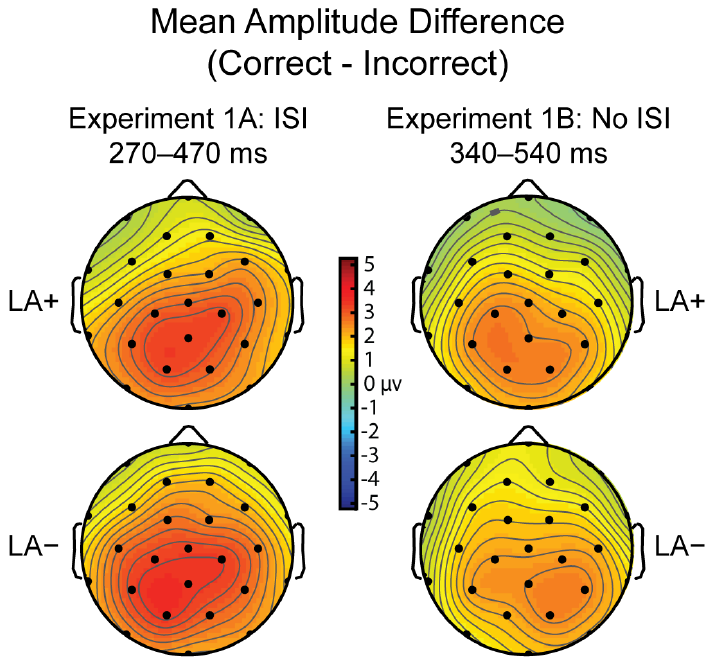
Figure 6. Topographic (isovoltage) maps of the correctness effect (correct–incorrect) for each language between 270 and 470 ms after solution onset for Experiment 1A (left) and between 340 and 540 ms after solution onset for Experiment 1B (right).